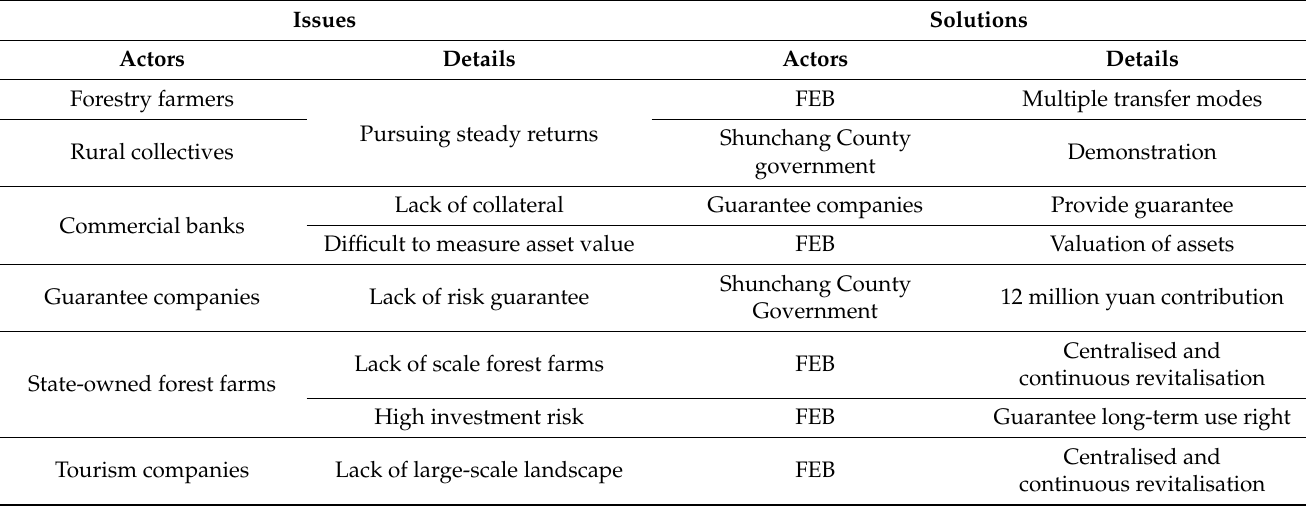
Table 2. Issues encountered in the recruitment and mobilisation of typical cases and their